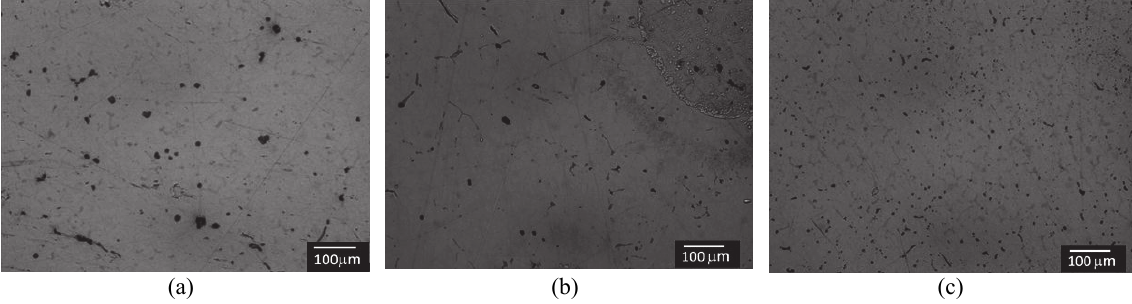
Fig. 2. Optical micrographs of (a) A2; (b) B1; and (c) C3